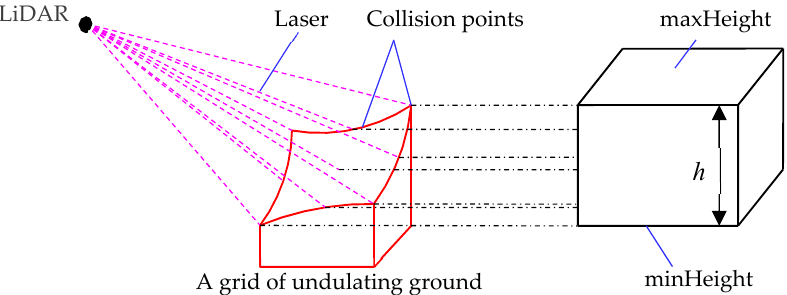
Figure 14. Schematic diagram of 3D LiDAR terrain detection.